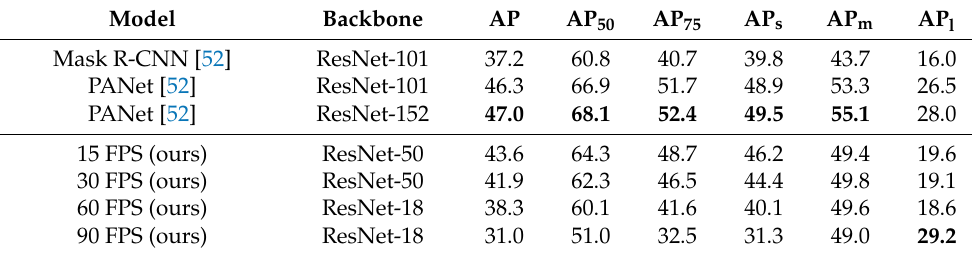
Table 2. Comparison of our proposed object detector to different results published for the iSAID. All evaluations are executed on the test set.